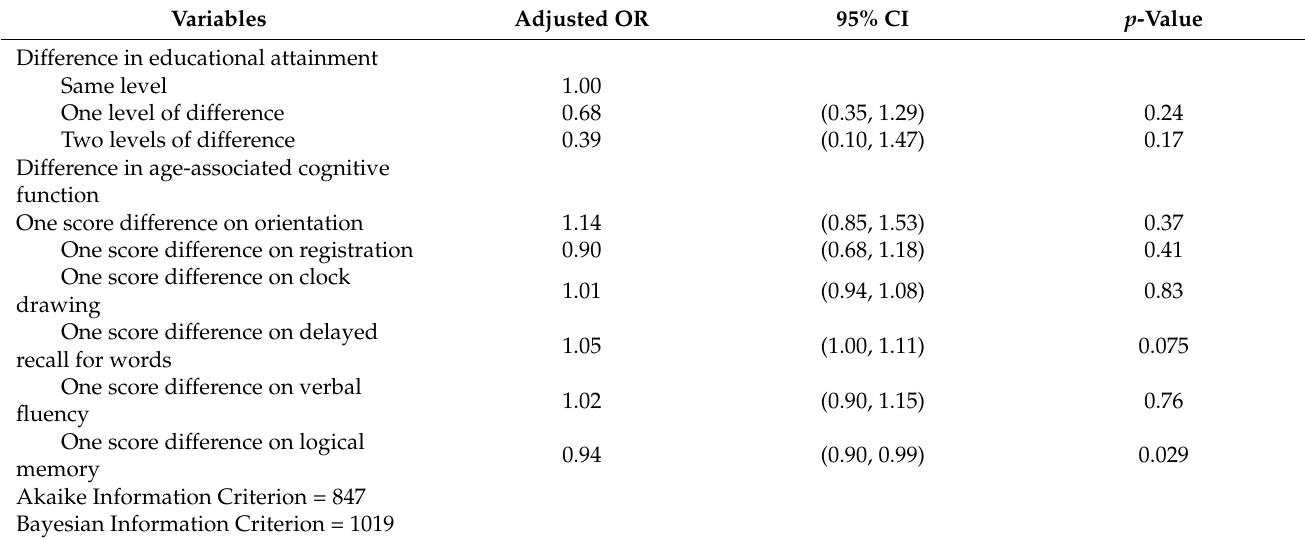
Table 2. Exponential Random Graph Models predicting confidant ties among older adults based on difference in age-associated cognitive functions between nodes among the participants ( n = 252).